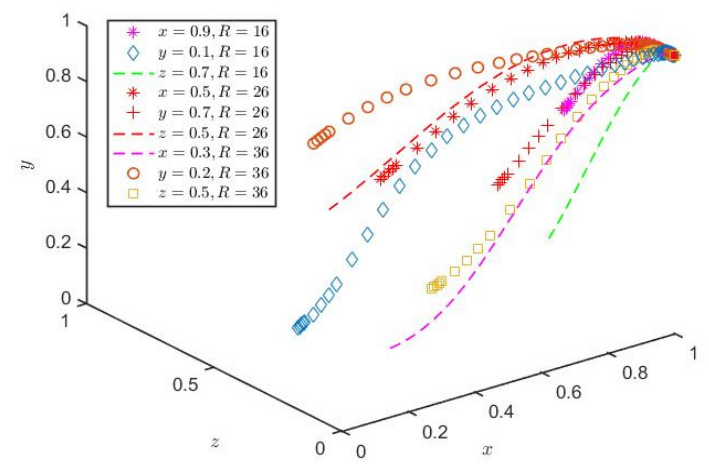
Figure 3. Effects of different accounts receivables on evolutionary game strategies.